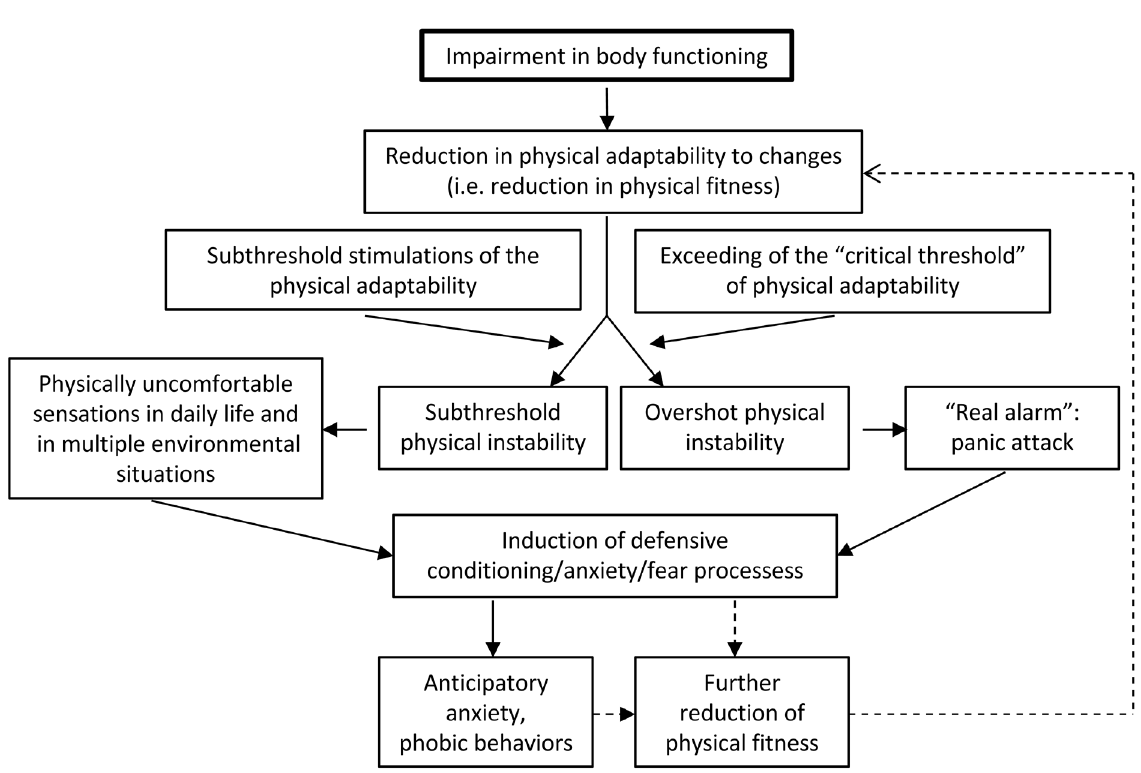
Figure 1. A heuristic model describing hypothesized relationships between the impairment in body functioning and panic